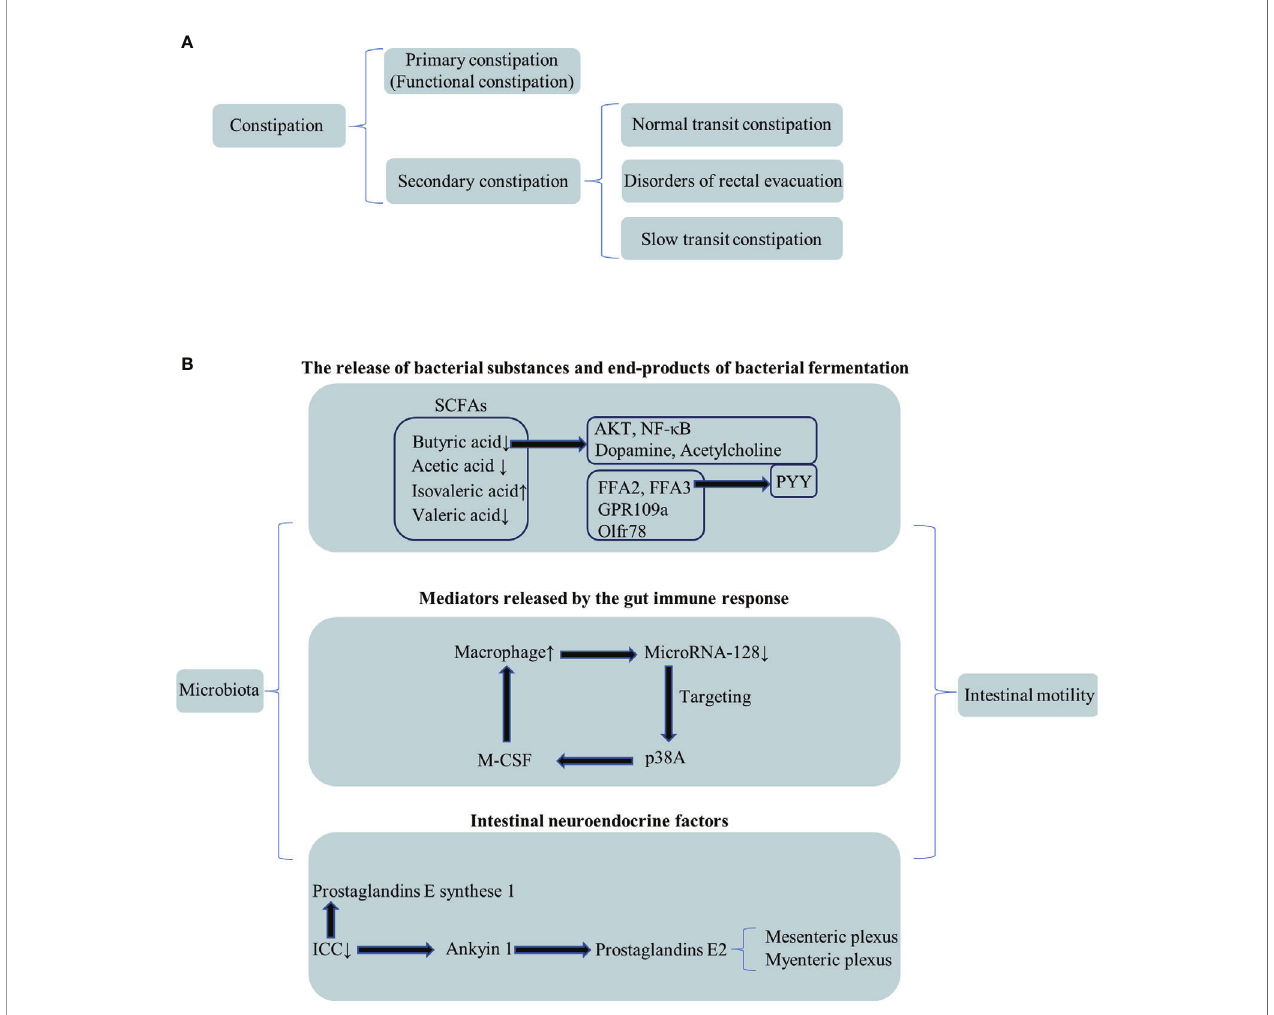
FIGURE 1 | Classi fi cation of constipation and relationship among the microbiota and intestinal motility. (A) Secondary classi fi cation of constipation. (B) The relationship between the microbiota and intestinal motility through three